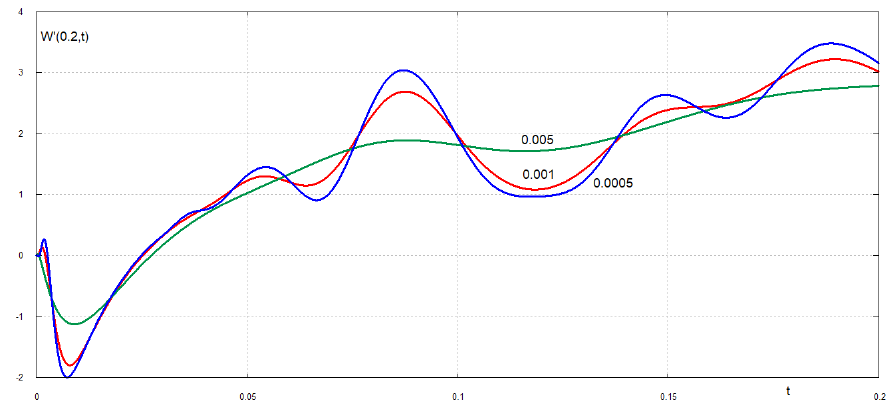
Figure 7. Dimensionless velocity of the plate at x = 0.2 shortly after after the plate breaking for very small values of the dimensionless retardation time ˜ τ = 0.001,0.005,0.0005.